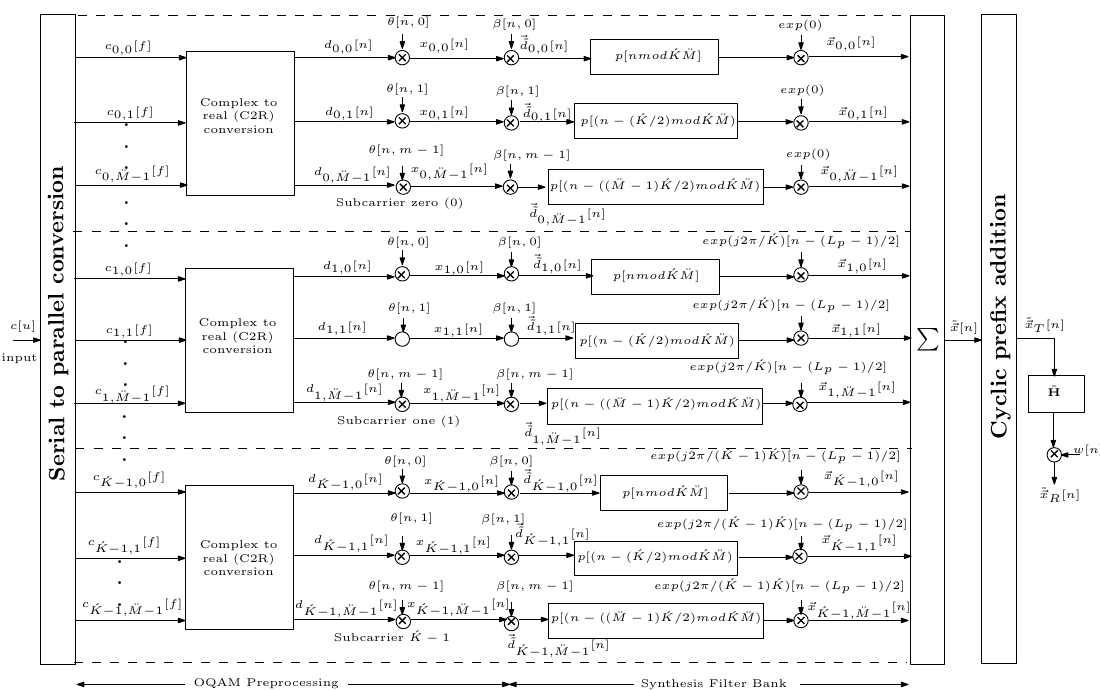
Figure 20. Structure of GFDM-OQAM based